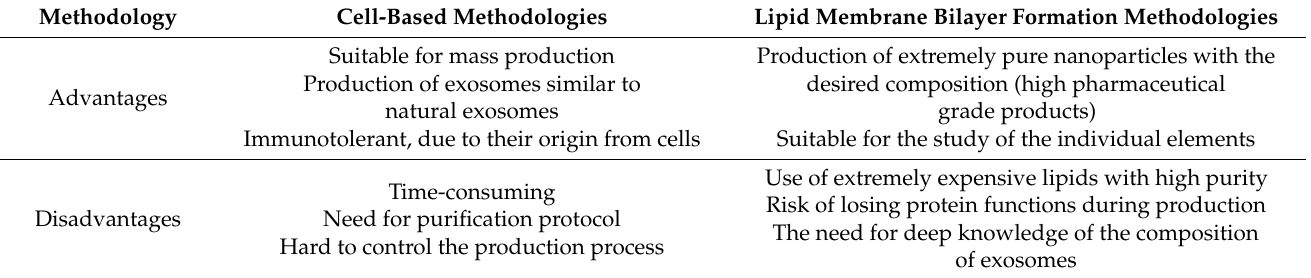
The main advantages and disadvantages of the various methods for synthetic exosome production